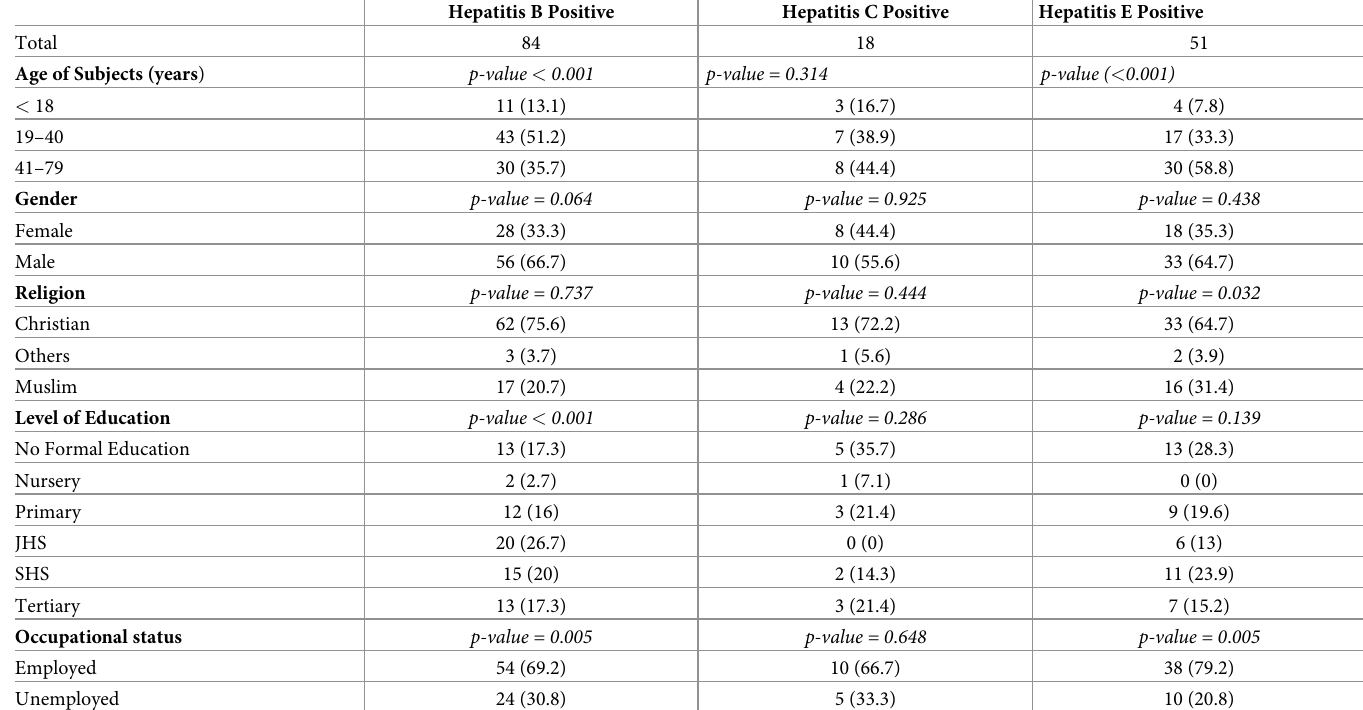
Table 5. Socio-demographic characteristics of study subjects stratified by hepatitis viruses.